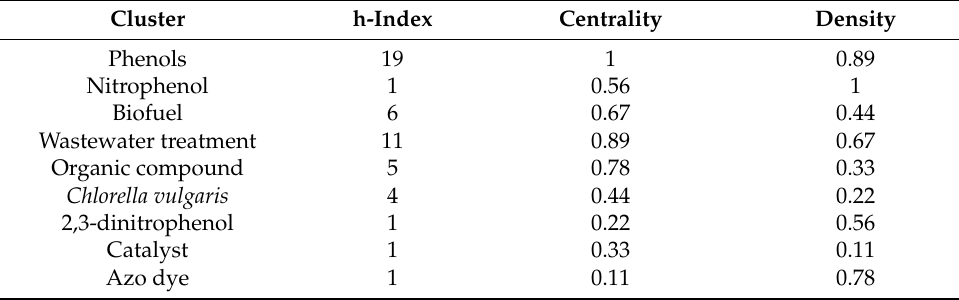
Figure 10. Schematic diagram for the fourth period (2016–2020). Table 4. The measures for themes of the fourth period